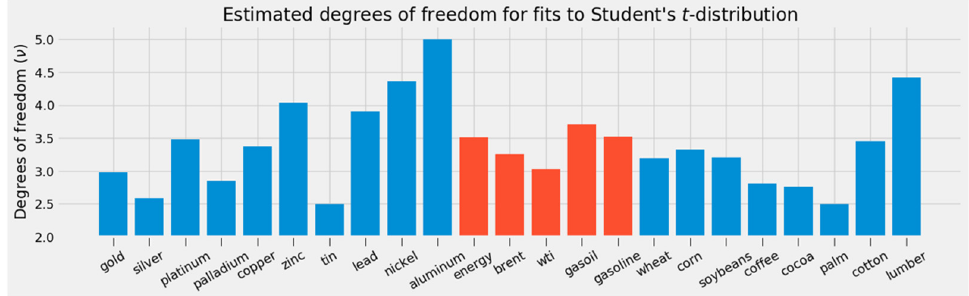
Figure 26. Hierarchical agglomerative clustering of energy-related markets—the t -SNE manifold revisited, with clusters of interest indicated by their centroids.